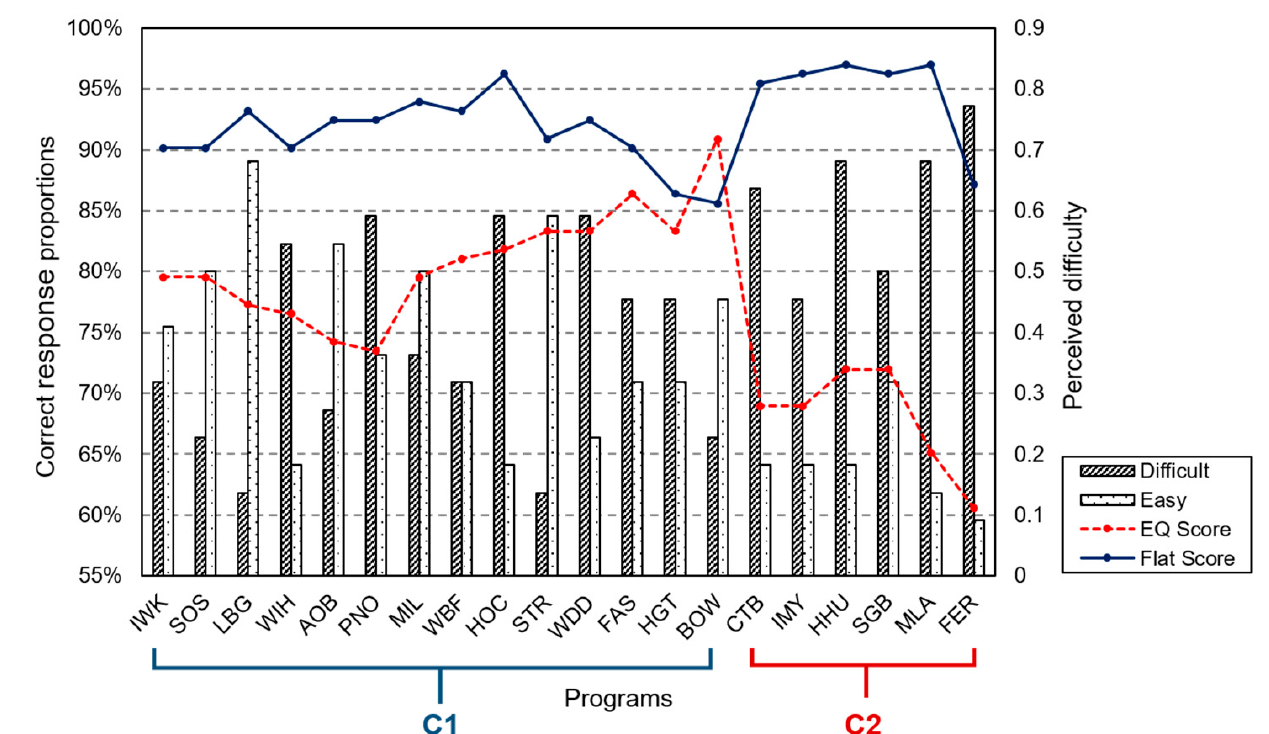
Figure 5. The EQ Score, Flat Score, and listener’s perceived difficulty for each program. “Difficult” and “Easy” indicate the times of the program mentioned as difficult or easy to conduct the test in the post-test questionnaire. C1 and C2 represent the two clusters.